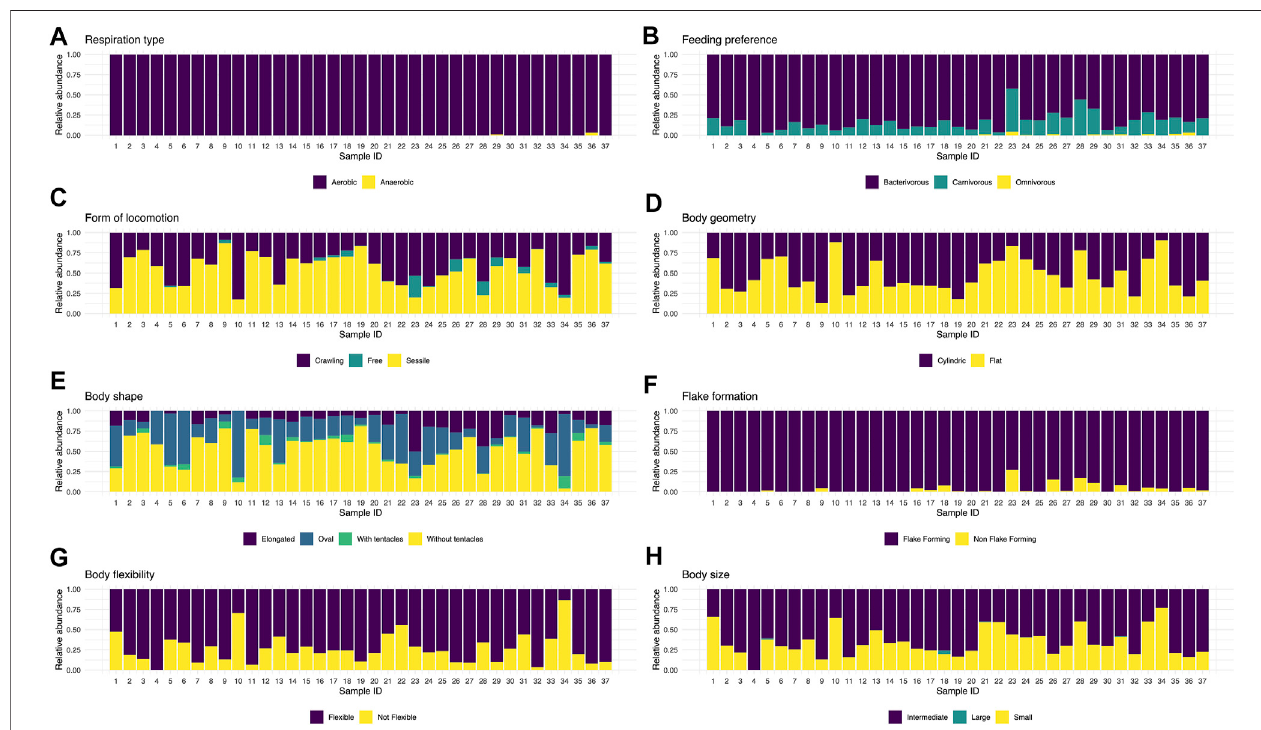
FIGURE2| CWMvalueforthedifferentfunctionaltraitschosenfortheciliatesrecordedthroughout37samplingsinawastewatertreatmentplantinBrazil,Piçarrão